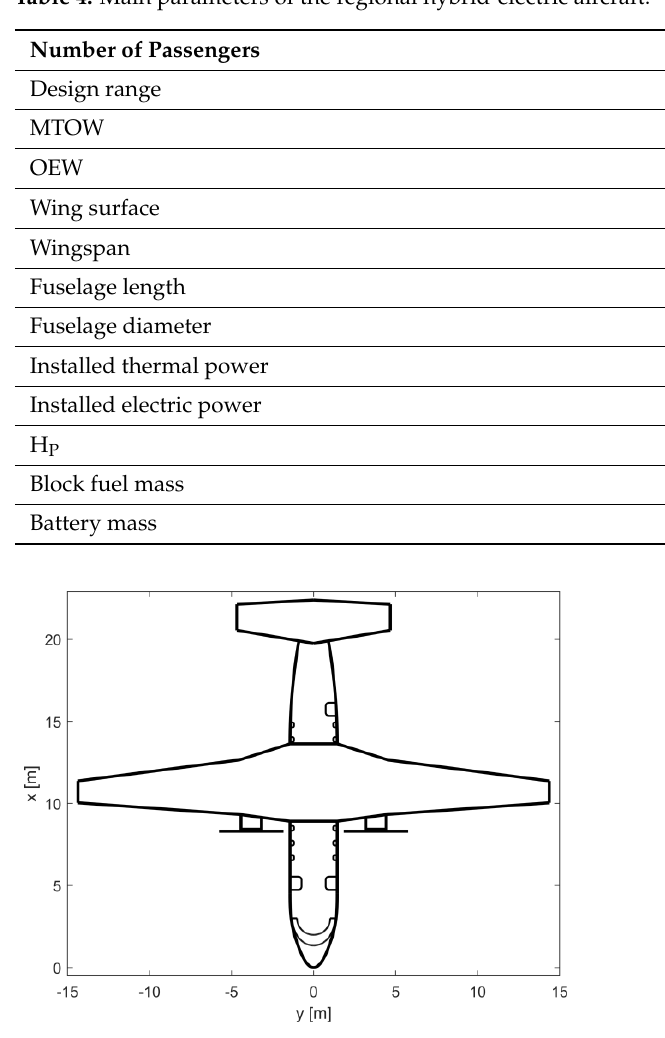
Figure 8. Planform of the hybrid-electric regional aircraft.